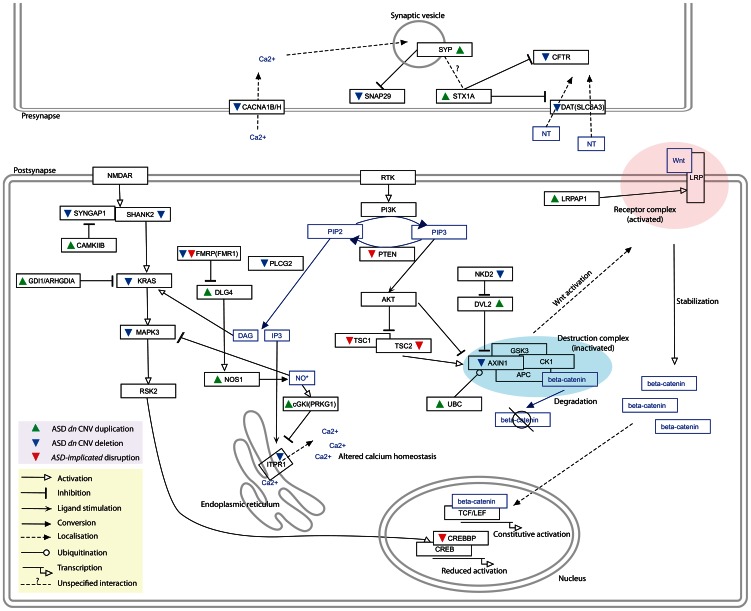
Distinct duplications and deletions of genes whose proteins interact within the ASD-associated network perturb pathways in the same direction.Genes duplicated within ASD dn CNVs are indicated with green upwards arrows while those deleted are denoted by blue downwards arrows. Previously identified ASD-Implicated genes found to be disrupted in autism patients are denoted with red downwards arrows. The nature of the interactions/regulations between proteins/molecules are shown with different edge types (see in-figure legend). The ASD-associated network (Figure 2) identifies several deletion/duplication pathway cascades, for example the MAPK3 pathway (see Discussion for additional examples). Here, deletions of the MAPK3 pathway components (i.e. SYNGAP1, SHANK2, KRAS, MAPK3, PAK2, and CREBBP) and duplications of their negative regulators (i.e. FMR1, GDI1, ARHGDIA, CAMK2B, and CAMKK2) found in autistic patients identify converging effects on the MAPK pathway, specifically reduced CREB-dependent transcription [9], [62], [63], [64]. CREB-dependent transcription has been implicated in neuroadaptation [20]. In addition, increased NO* production leads to the inhibition of MAPK1/3 activity [65], which fits well with the observed CNV duplications of both NOS1 and DLG4, the latter gene promoting recruitment of NOS1
[66]. Similarly, duplication of PRKG1, which is up-regulated by NO* and expresses a product that inhibits IP3 production, is predicted to reduced activation of the calcium-releasing IP3-receptor ITPR1
[67], which is in turn found to be deleted.